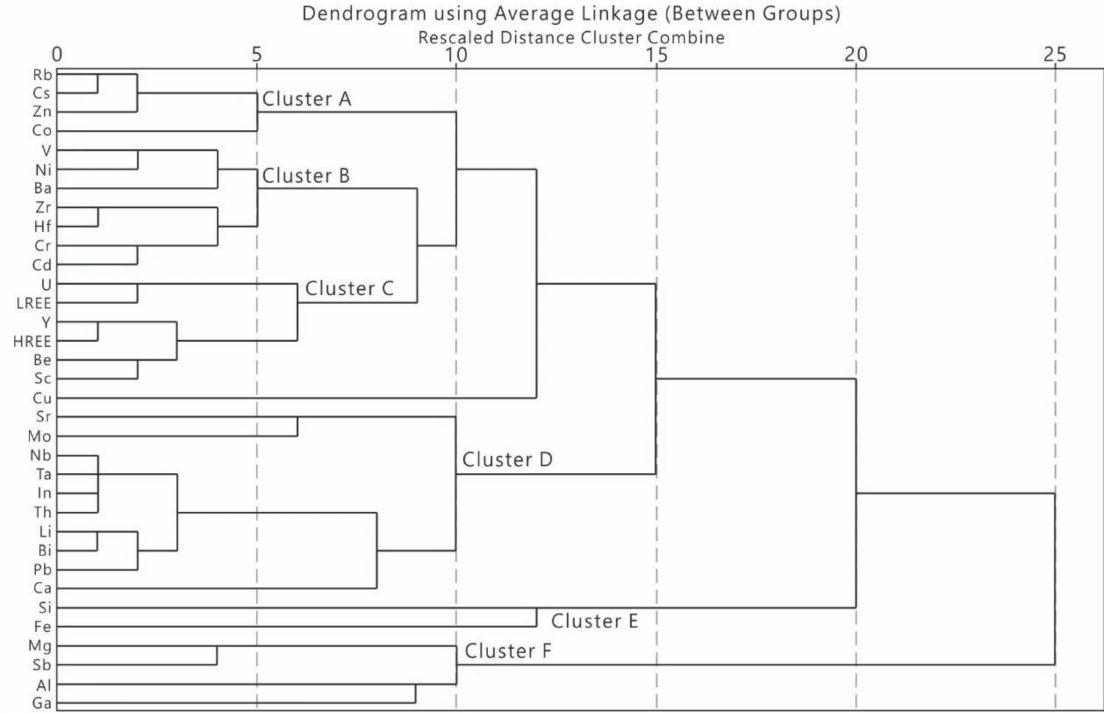
Figure 5. Dendrogram of HCA for Ga-In-enriched horizons (Measurement criteria: Pearson’s correlation coefficient, n =